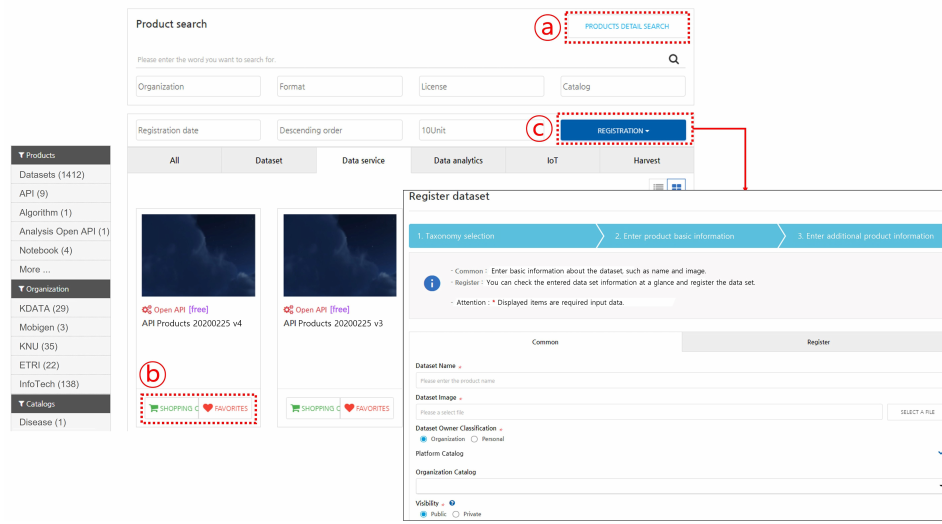
Figure 12. Functions of the Category